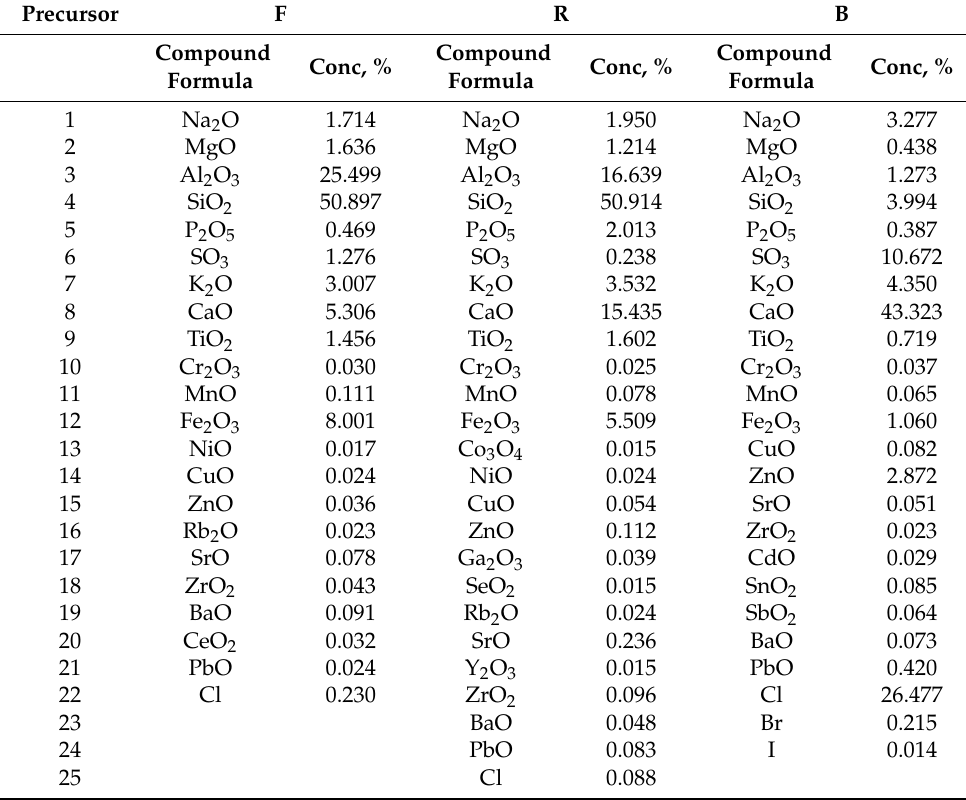
Table 3. The analyzed chemical formula of tested fly ashes.